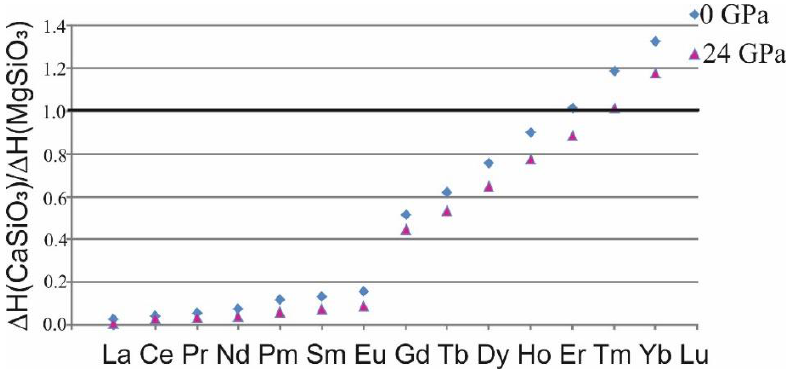
Figure 4. Mixing enthalpy of solid solutions of CaSiO 3 ( a ) and MgSiO 3 ( b ) with hypothetical REE perovskites.